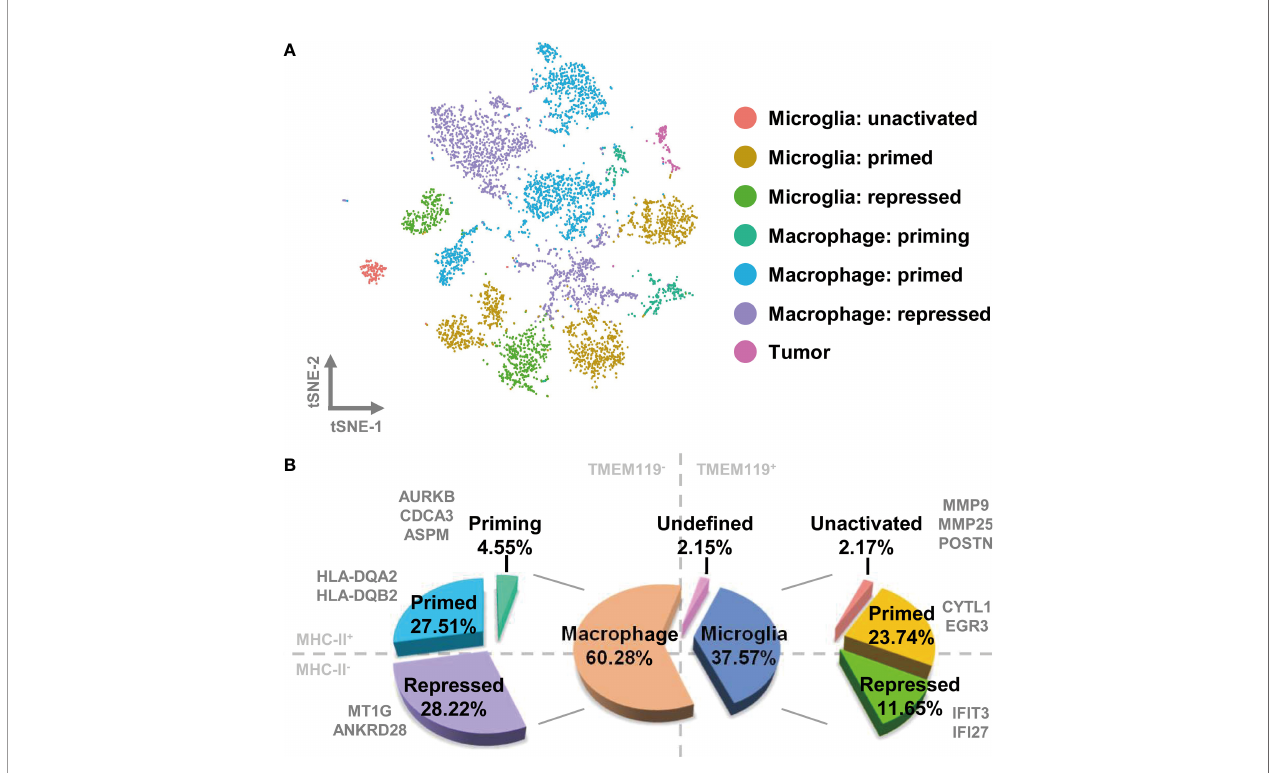
FIGURE 2 | TAMs inGBM comprise different activation states of bonemarrow – derived macrophages andbrain-resident microglia. (A) Eachcelltypeisvisualized as a t-SNE plot. (B) The relative proportionsof macrophages and microgliaare 60.28% and 37.57%,respectively.Theratioof detailedTAM states isshown inthe pie